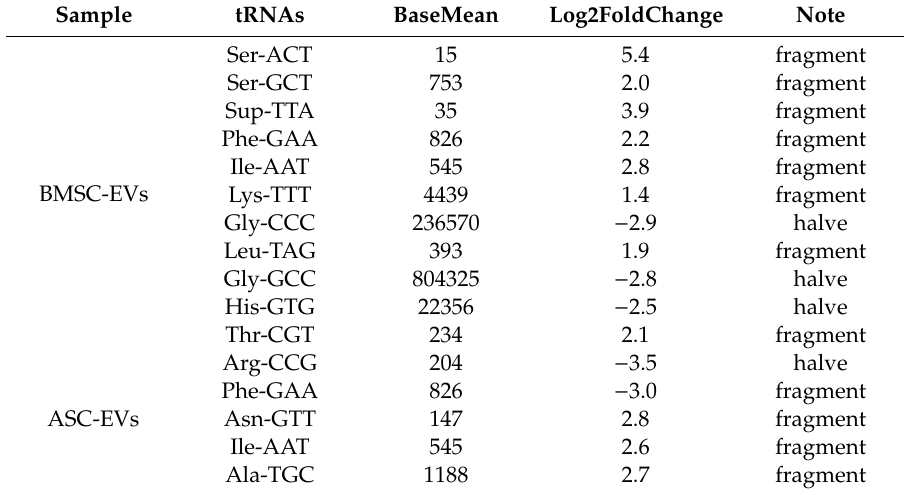
Table 5. tsRNAs with di ff erential expression upon osteoblastic di ff erentiation (D7 vs.